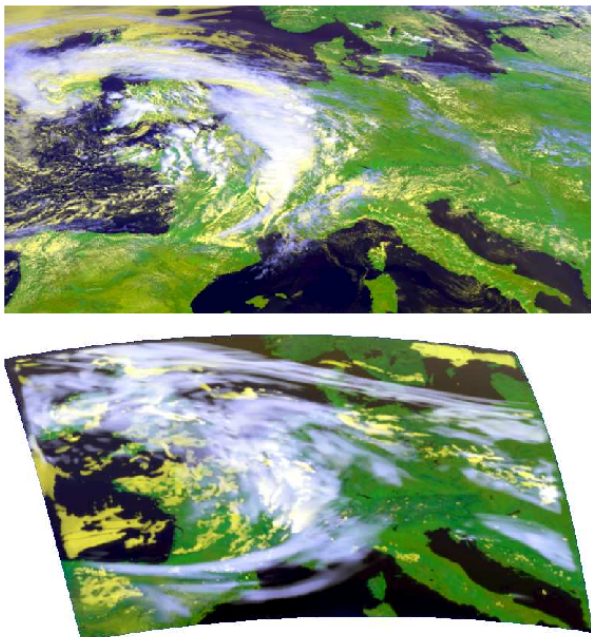
Fig. 6. (Top) false colour composites of a real MET-8/SEVIRI ob- servation from 12 August 2004, 12:00 UTC; (bottom) simulated satellite observation, for the same date and time and processed by the same false colour